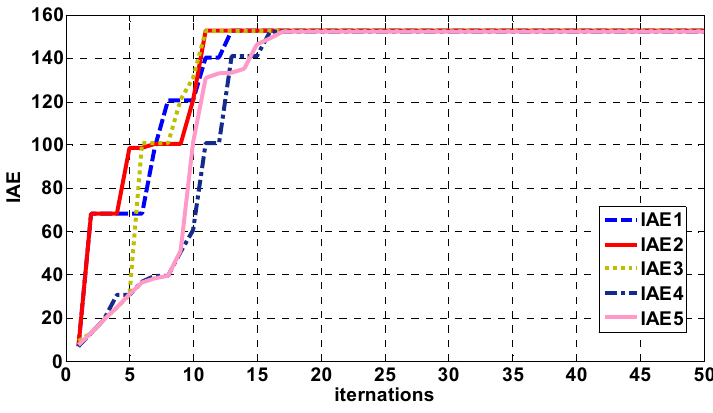
Figure 4. IAE convergence curve using